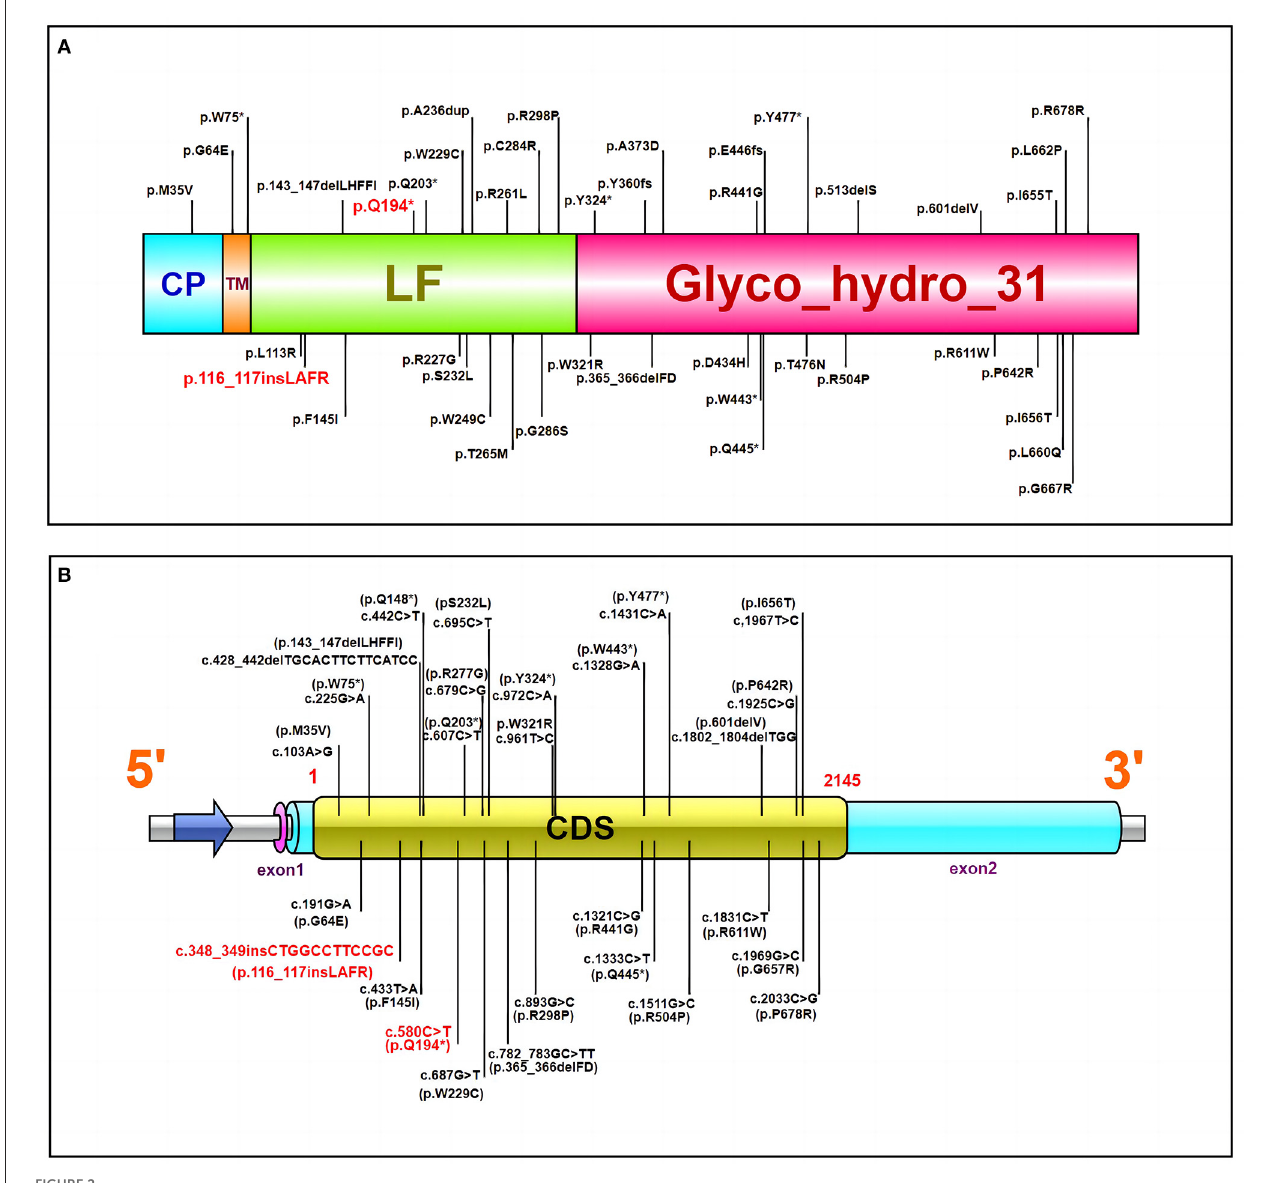
FIGURE2 (A) The MYORG protein and reported variants. Domain architecture of the MYORG protein and previously reported variants; the variant in our case is marked in red. CP, cytoplasmic domain; TM, transmembrane domain; LF, C-terminal luminal fragment with a glycosidase domain. (B) The MYORG cDNA and reported variants. The variant in our case is marked in red. CDS Coding sequence (the length is ∼ 2,145 bps). * Manifestation of nonsense